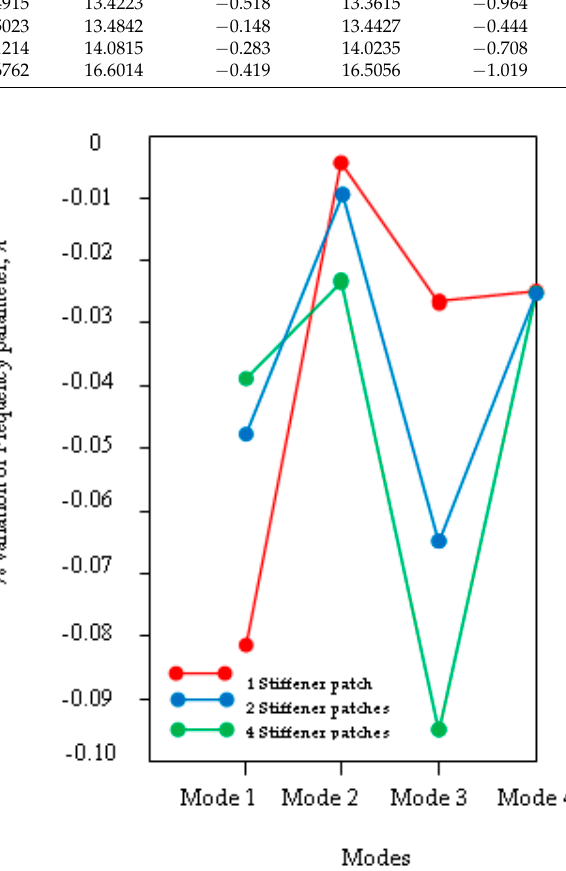
Figure 5. Comparison of % variation of natural frequency parameter with different modes for plate with taper ratio, T x = 0.00 and with different attachments of rectangular stiffener patches.